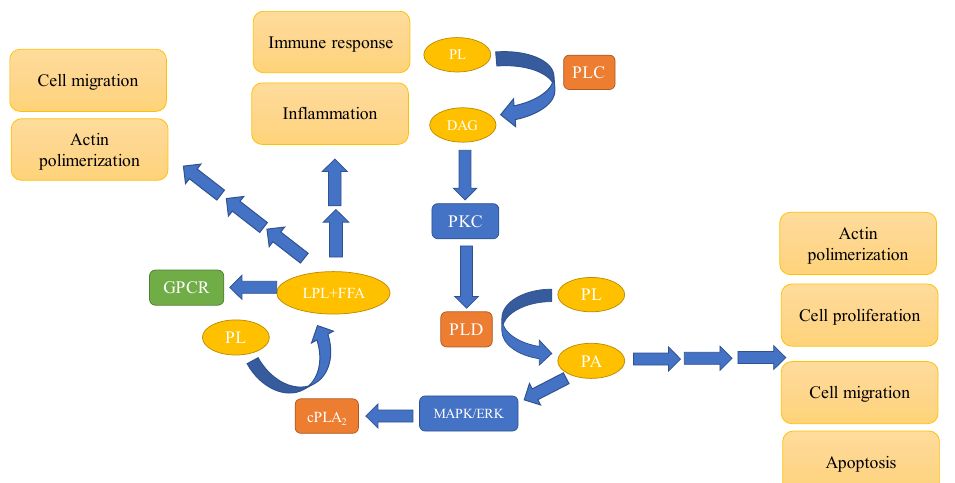
Figure 3. Simplified scheme of the interaction of phospholipases or products of their interaction with other enzymes in the intracellular signaling pathways and the processes they regulate. Abbreviations: cPLA 2 —cytosol phospholipase A 2 ; PLC—phospholipase C; PLD—phospholipase D; PL—phospholipid; FFA—free fatty acid; DAG—diacylglycerol; PA—phosphatidic acid; PKC—protein kinase C; MAPK/ERK—mitogen activated protein kinase/extracellular-signal-regulated kinase; GPCR—heterotrimeric G-protein coupled receptor. Phospholipases exhibit their activity on the membrane, where their substrates, PLs are located. Multiple arrows in the figure indicate the effect with several intermediate enzymes, whereas one arrow indicates a direct interaction of the lipid second messenger and the enzyme.